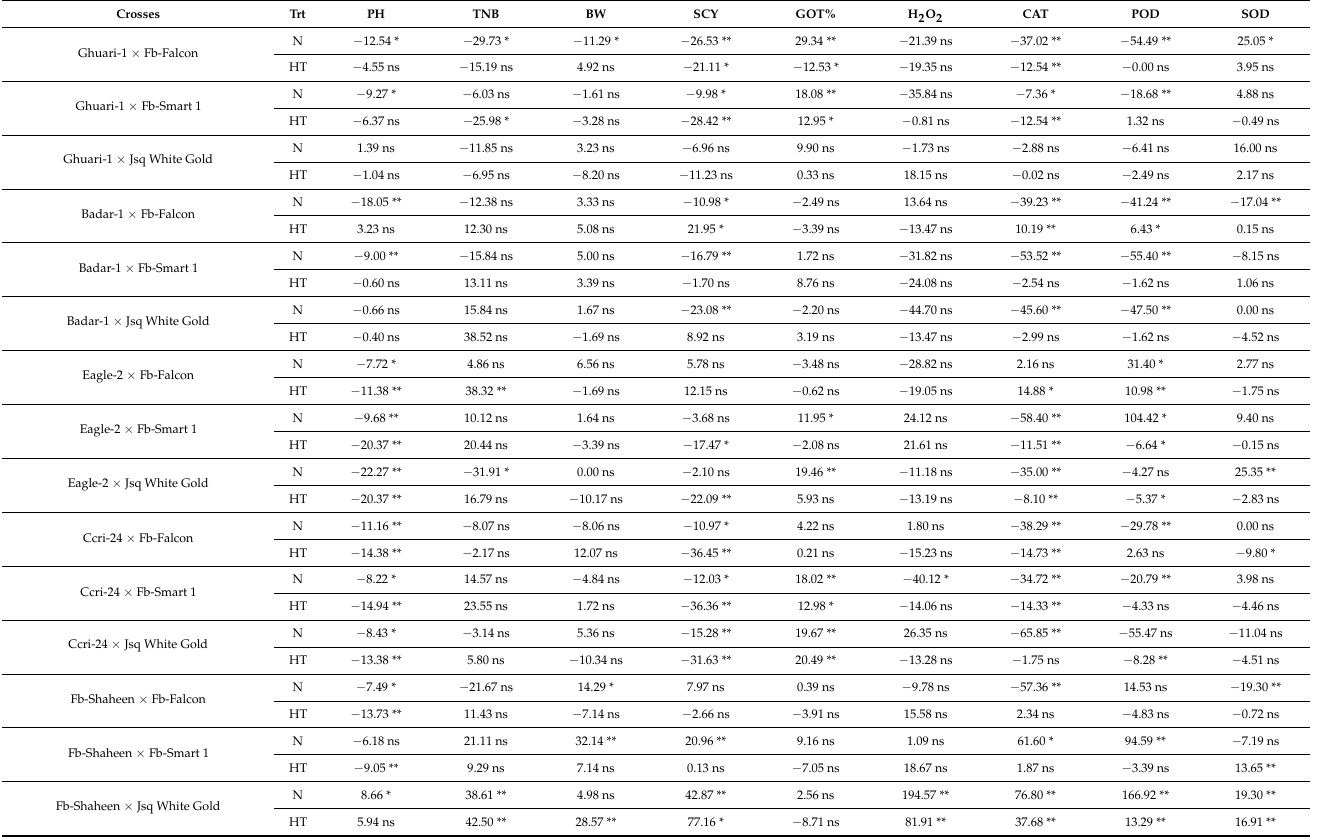
Table 12. Second year heterosis effects of various traits under normal and high temperature stress